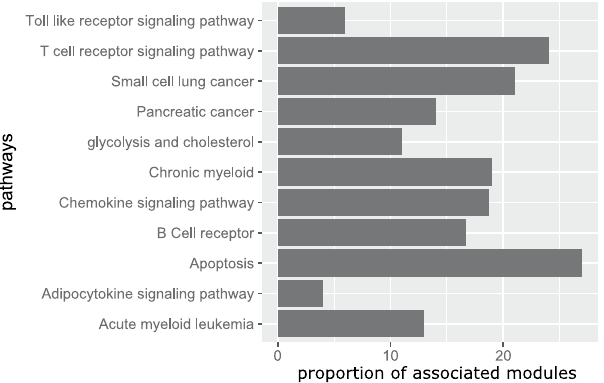
Figure 10. Bar diagram showing the proportion of modules associated with 11 HIV specific pathways.